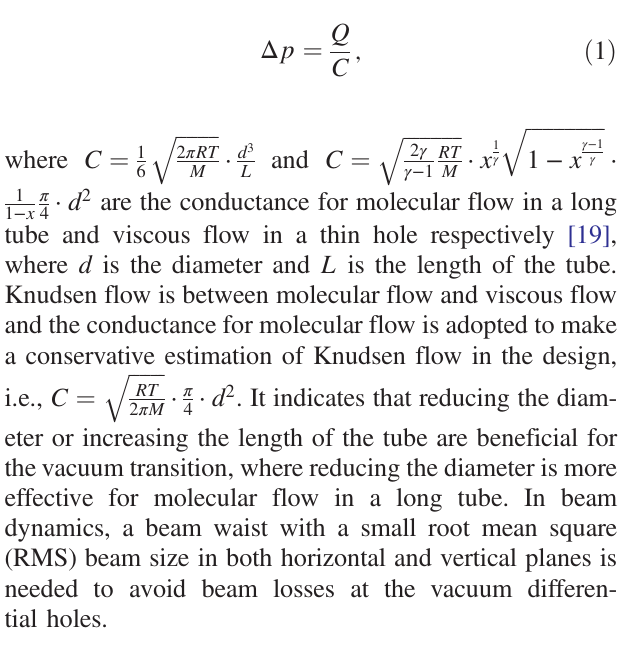
(cid:28615)(cid:28641)(cid:28629)(cid:28640)(cid:28640)(cid:28564) (cid:28636)(cid:28643)(cid:28640)(cid:28633)(cid:28647)